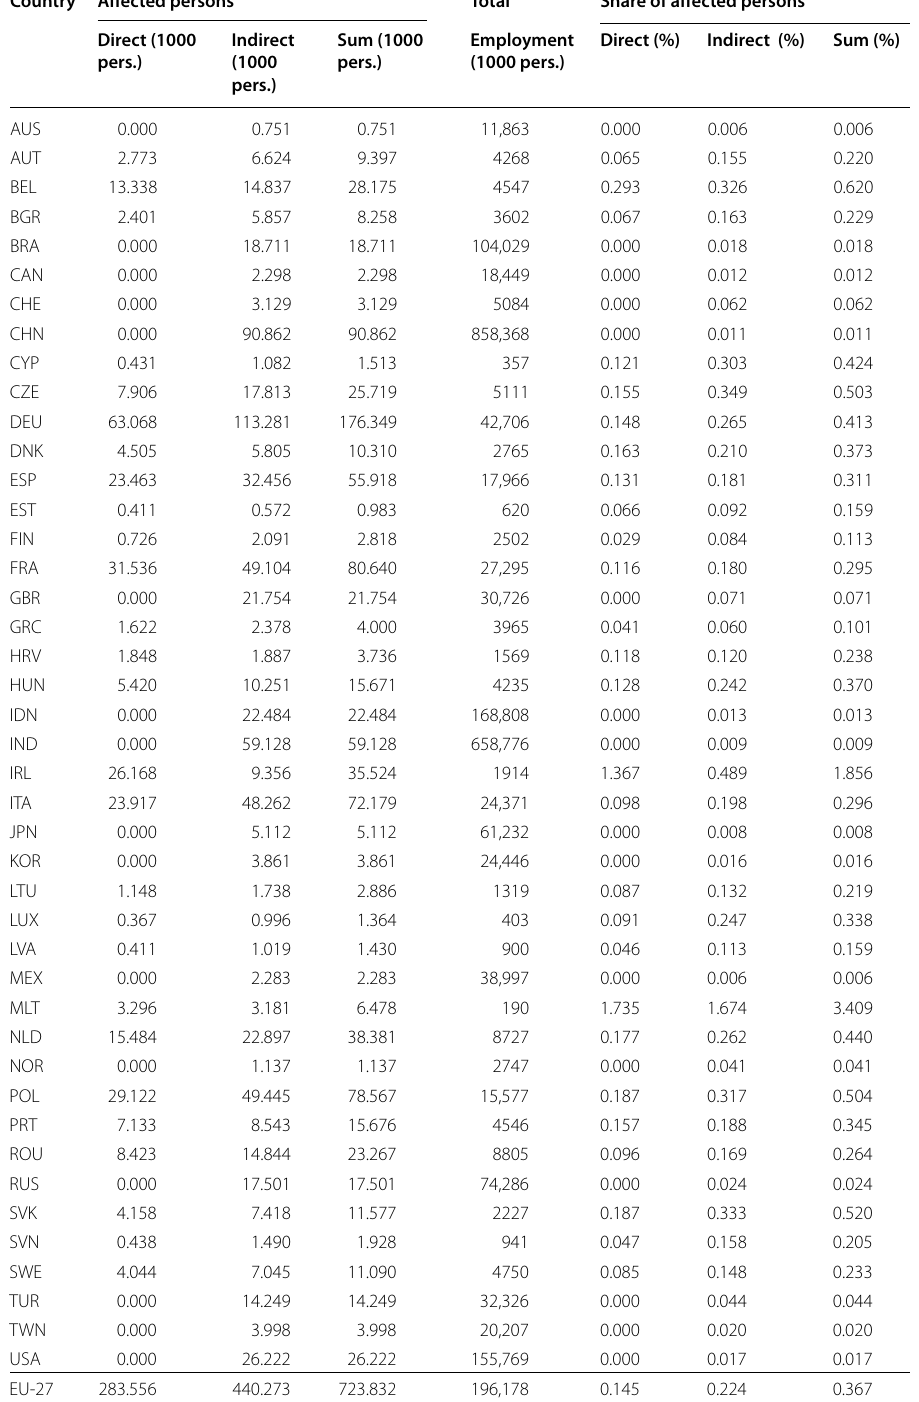
Table 3 Potential employment effects of a decline in UK import demand for final goods from the EU (no‑deal